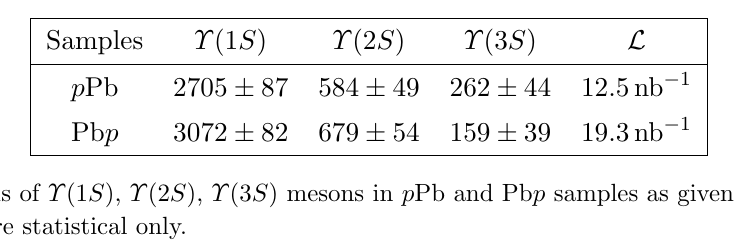
Figure 1 . Invariant-mass distribution of (cid:22) + (cid:22) (cid:0) pairs from the (left) p Pb and (right) Pb p samples after the trigger and o(cid:11)line selections.